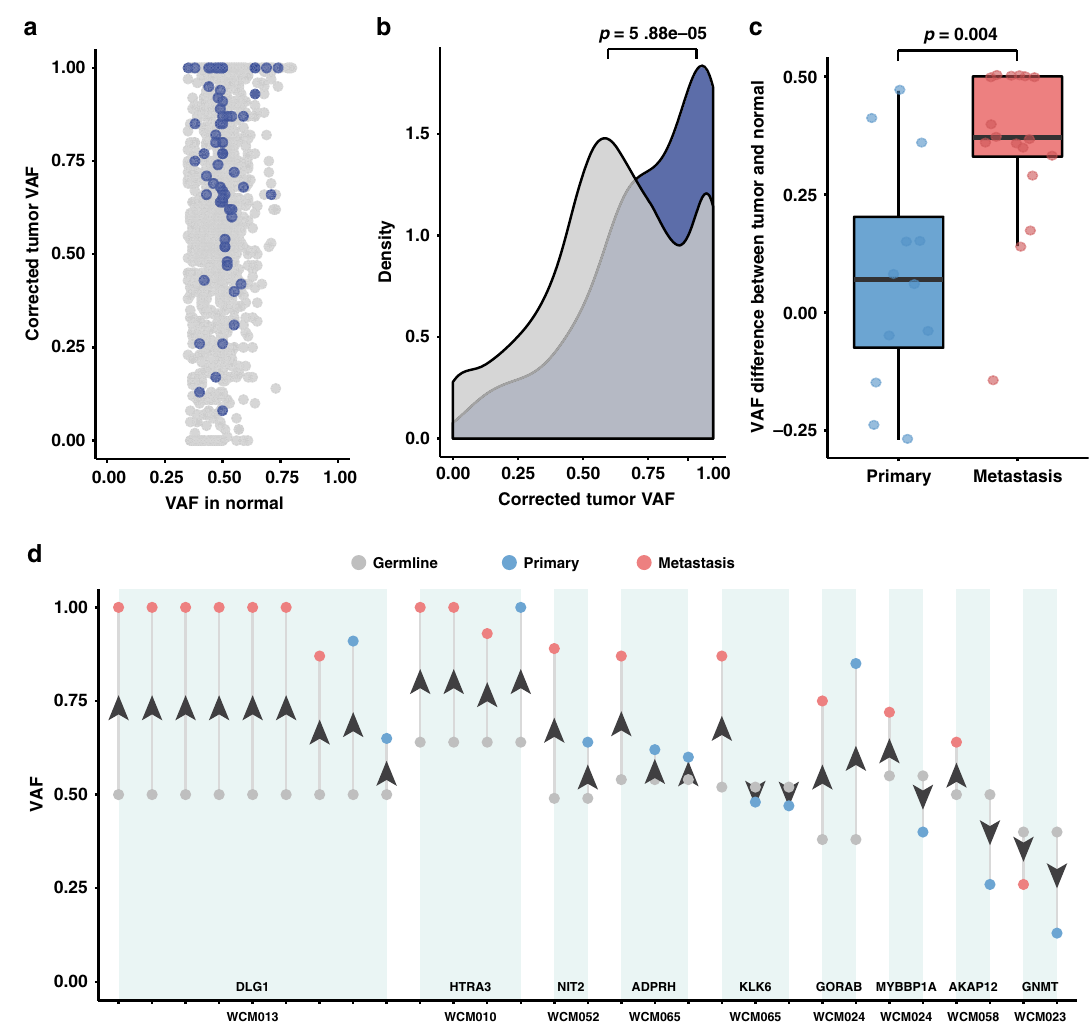
Fig. 5 Deepening loss of heterozygosity during UC progression. a A scatter plot displaying the normal and tumor VAFs of pDGVs in TSGs (blue dots) and protein-truncating germline variants in non-TSGs (gray dots). The majority of pDGVs have a tumor-to-normal VAF ratio ≥ 1.6. b A density plot representing the distribution of the VAFs of pDGVs affecting TSGs and protein-truncating germline variants affecting non-TSGs. The peak density of the VAF of pDGVs in TSGs (blue) is signi fi cantly higher than the density of the VAF of protein-truncating germline variants in non-TSGs (gray) using a two-tailed Kolmogorov – Smirnov test. c The median VAF of pDGV is signi fi cantly higher in metastatic tumors ( n = 17) compared to primary tumors ( n = 12) in UC using a two-tailed Wilcoxon signed-rank test. The lower and upper edge of the box indicate the 25th and 75th percentiles. The black line in the center of the box indicates the median value; the lower and upper whiskers indicate 1.5x the interquartile range. d Changes in the VAFs of pDGVs in matched primary and metastatic UC trios. Metastatic, primary tumors, and germline are displayed in red, blue, and gray, respectively. Source data are provided as a Source Data fi